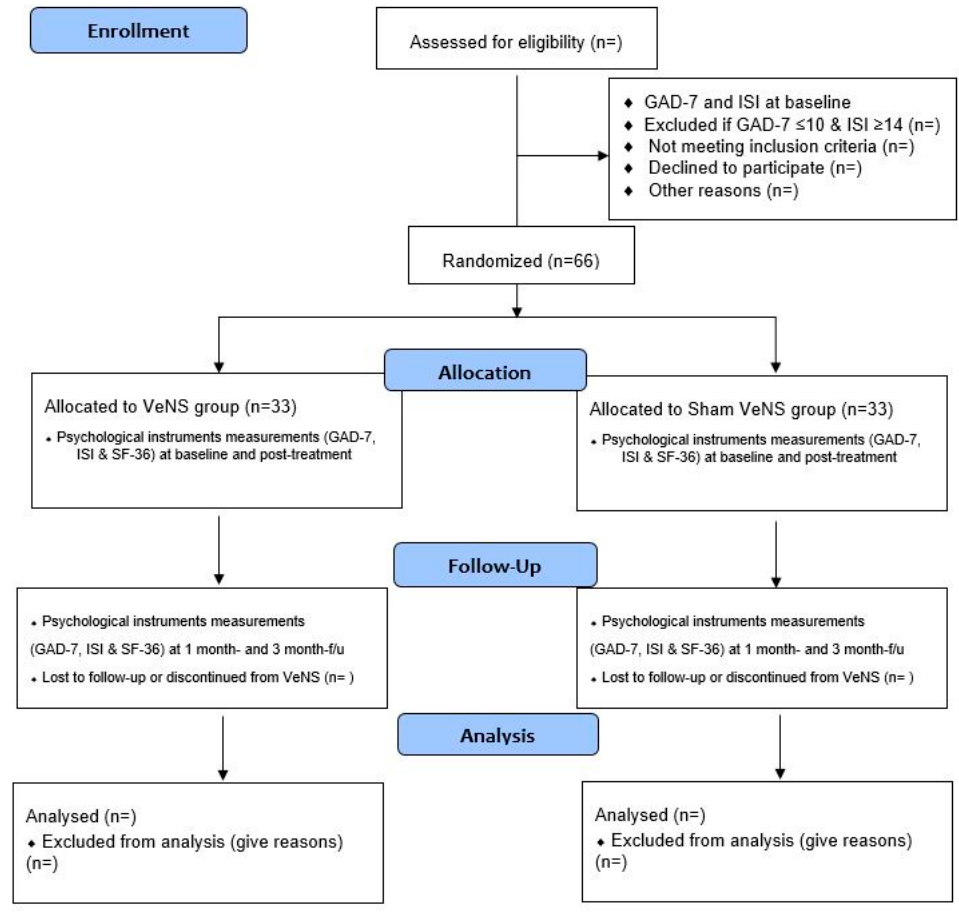
Figure 1. Flow diagram for participants’ enrollment, randomization, allocation, and follow-up.